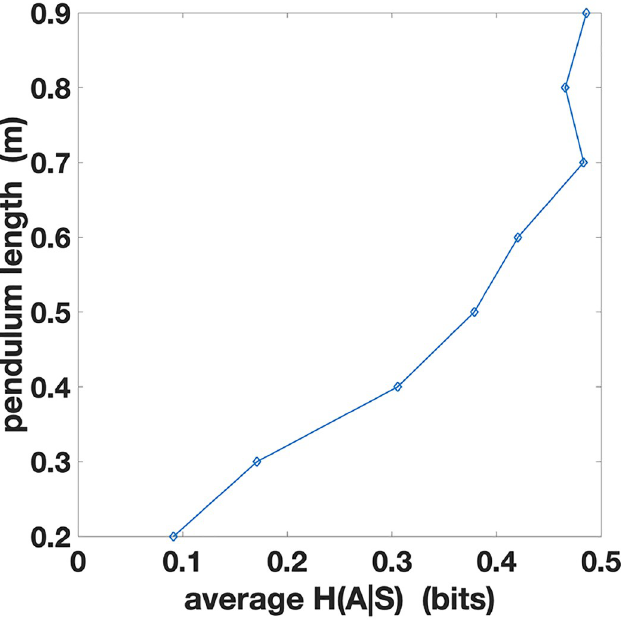
Fig 3. Action entropy H ( A | S ) averaged over trials with the same pendulum length L . The abscissa represents the action entropy and the ordinate represents the pendulum length to allow direct comparison with Fig